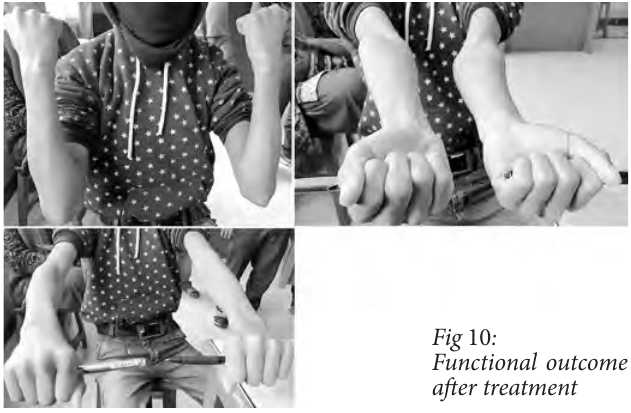
Fig 10 : Functional outcome after